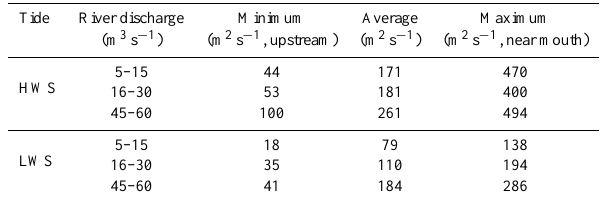
Table 2. Longitudinal dispersion coefficients of the SRE for different river